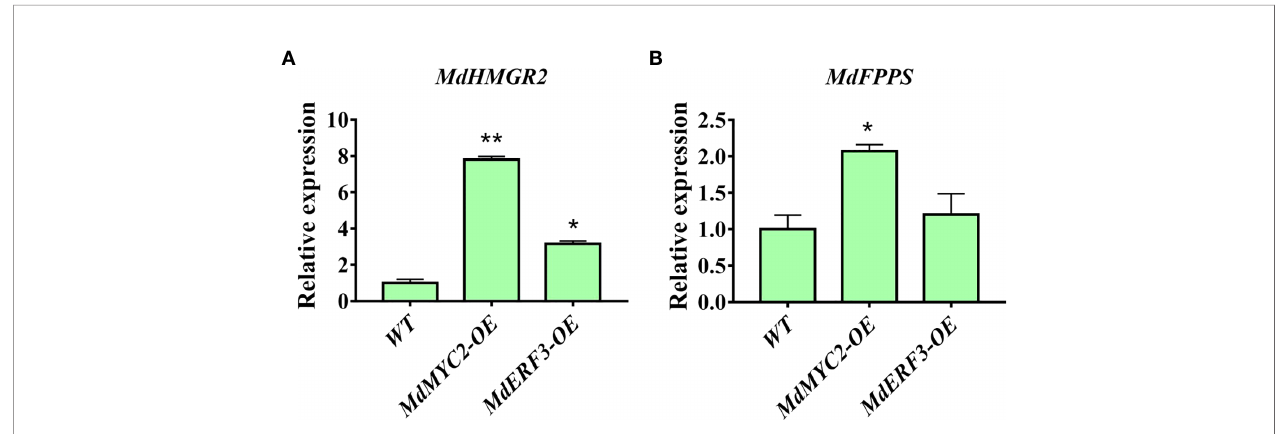
FIGURE 7 | Expression analyses of MdHMGR2 and MdFPPS in apple calli. (A) Expression analysis of MdHMGR2 in overexpressing MdMYC2 and MdERF3 apple calli. (B) Expression analysis of MdFPPS in overexpressing MdMYC2 and MdERF3 apple calli. Each value is expressed as mean ± SE (n = 3). * indicates P < 0.05 compared to WT and ** indicates P < 0.01 compared to